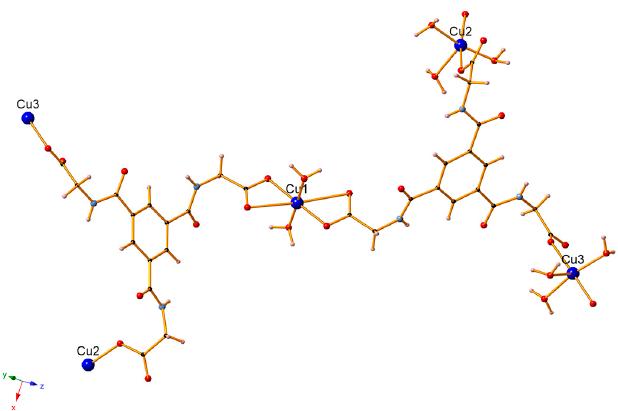
Figure 1. The crystal structure of 1 . Lattice water molecules are omitted for clarity. Colour code: Cu (blue), C (black), H (light pink), N (light blue), O (red).